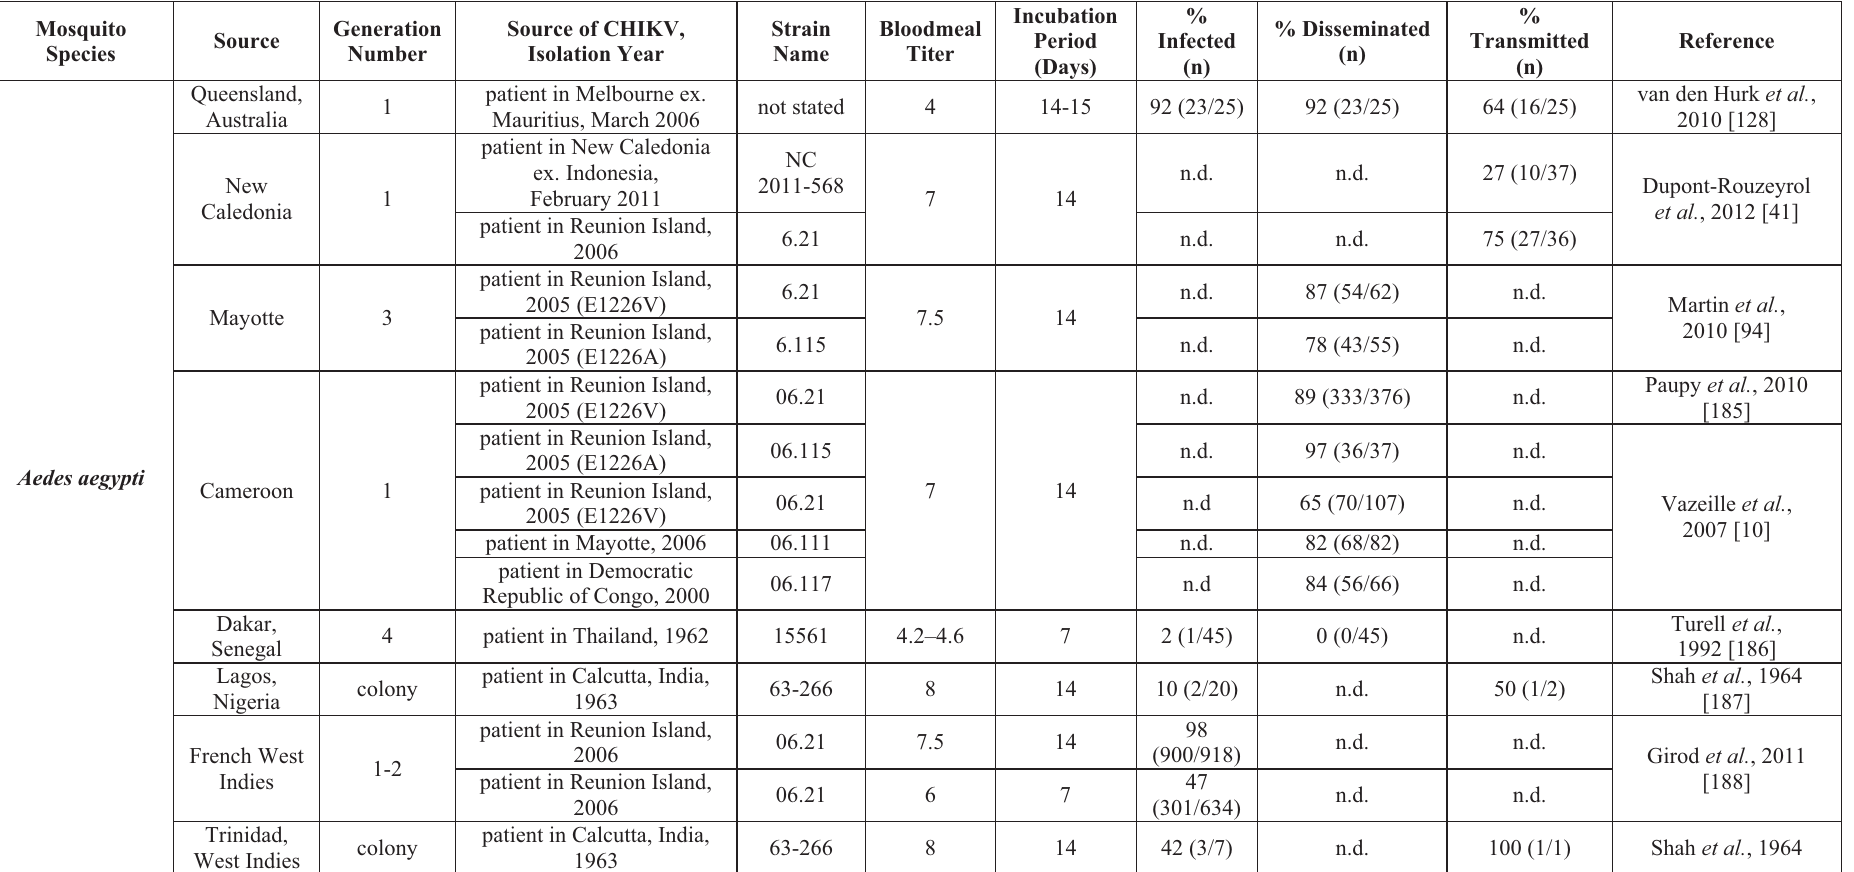
Table 1. Chikungunya virus vector competence in arthropods. Infection was ascertained by detection of virus in bodies of bloodfed mosquitoes; dissemination was determined by detection of virus in legs or heads. Transmission was verified by detection of virus in saliva or by infection of vertebrates after re-feeding. CHIKV bloodmeal titers are expressed in in log 10 cell culture infectious dose 50 /mosquito, plaque forming units/mL, or suckling mouse infectious culture lethal dose 50 /mL. Mosquitoes were held at 28 °C during the incubation period, except where noted: * indicates incubation at 24 °C and ** denotes incubation at 16 °C. For simplification, cohorts of the same species that fed on the same strain at similar bloodmeal titers are represented as one value and bloodmeal titers are shown as